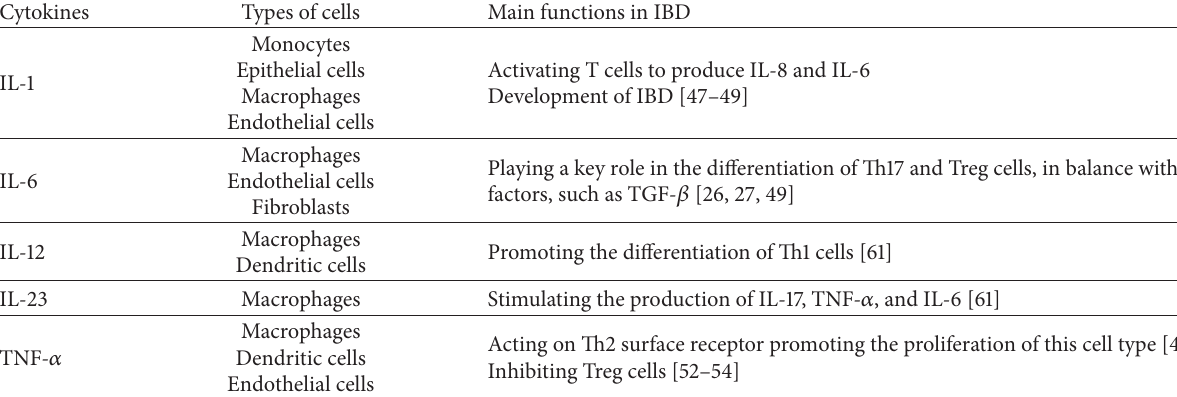
Table 1: Main cytokines of the innate immune response, cells that produce them, and the principle actions.